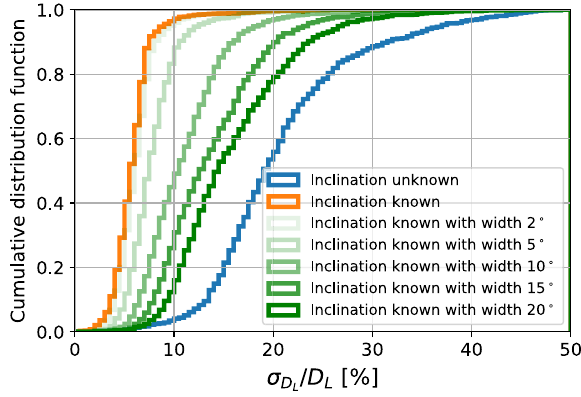
FIG. 6. Cumulative distribution function of the fractional luminosity distance uncertainty, which is calculated as the 1 σ uncertainty divided by the true value, for BNSs detected by Advanced LIGO-Virgo at design sensitivity.